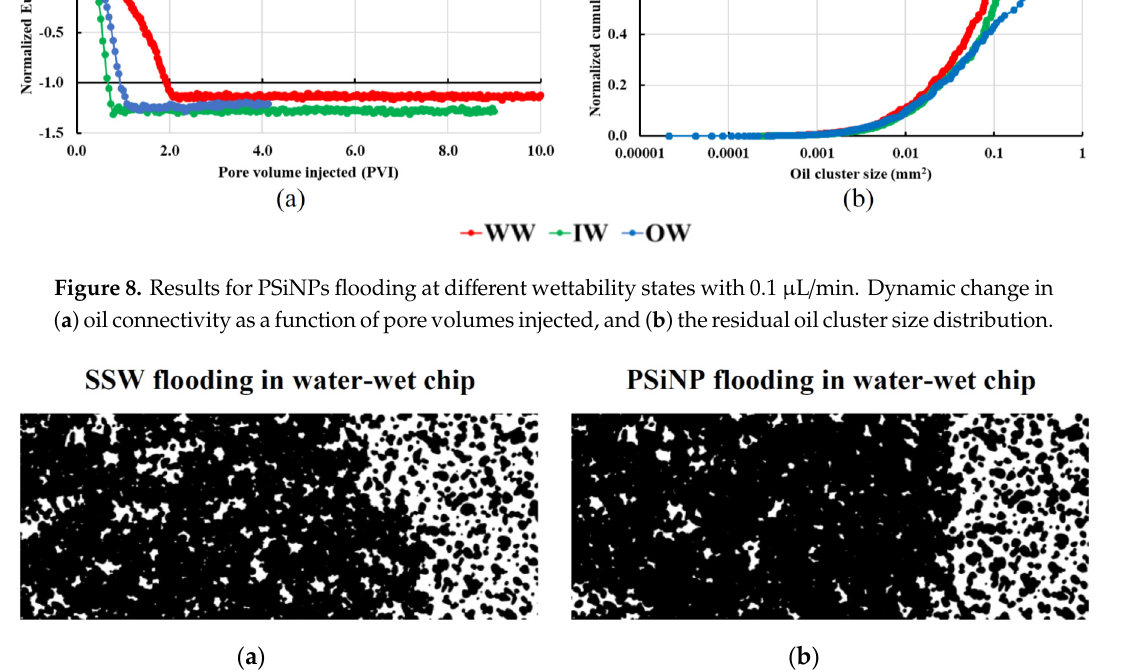
Figure 9. Displacement of the oil by the SSW ( a ) and PSiNPs ( b ) (oil: white; glass and water: black).